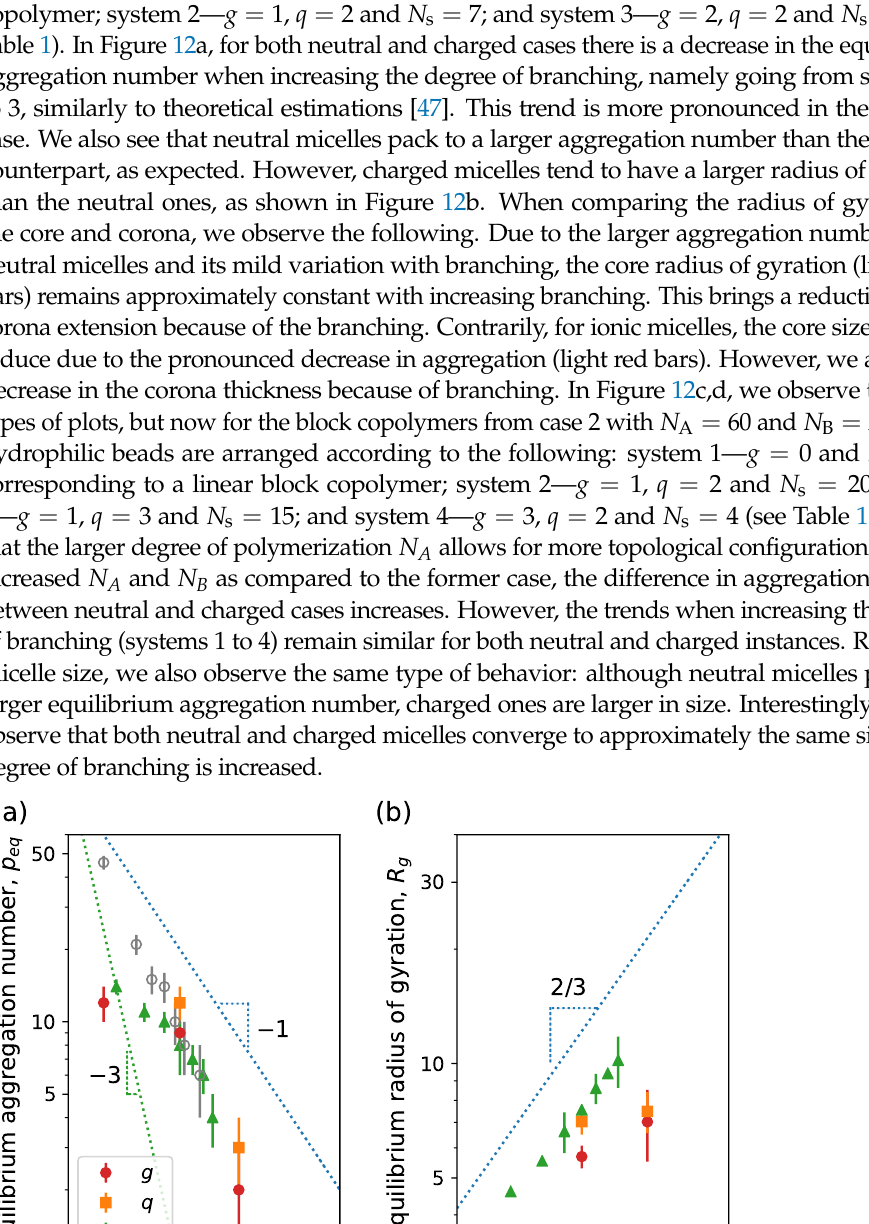
σ ; meanwhile, B σ . Other B